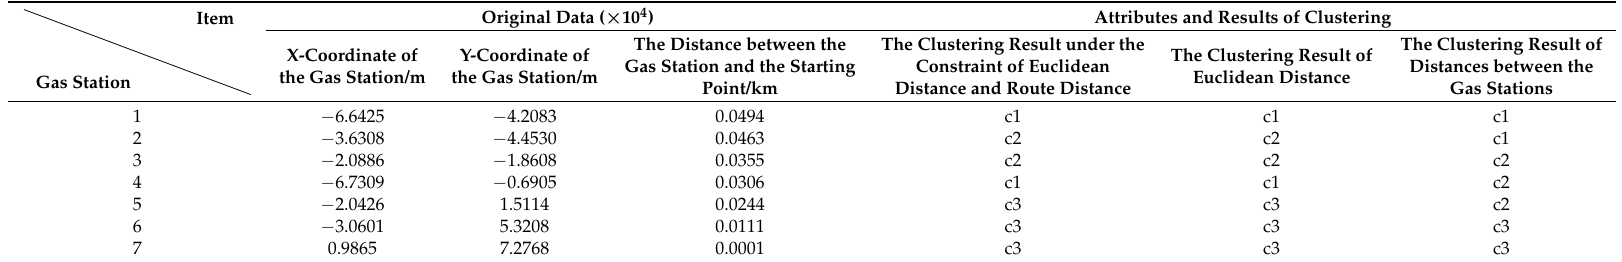
Table 3. Clustering effects comparison of different clustering attributes.